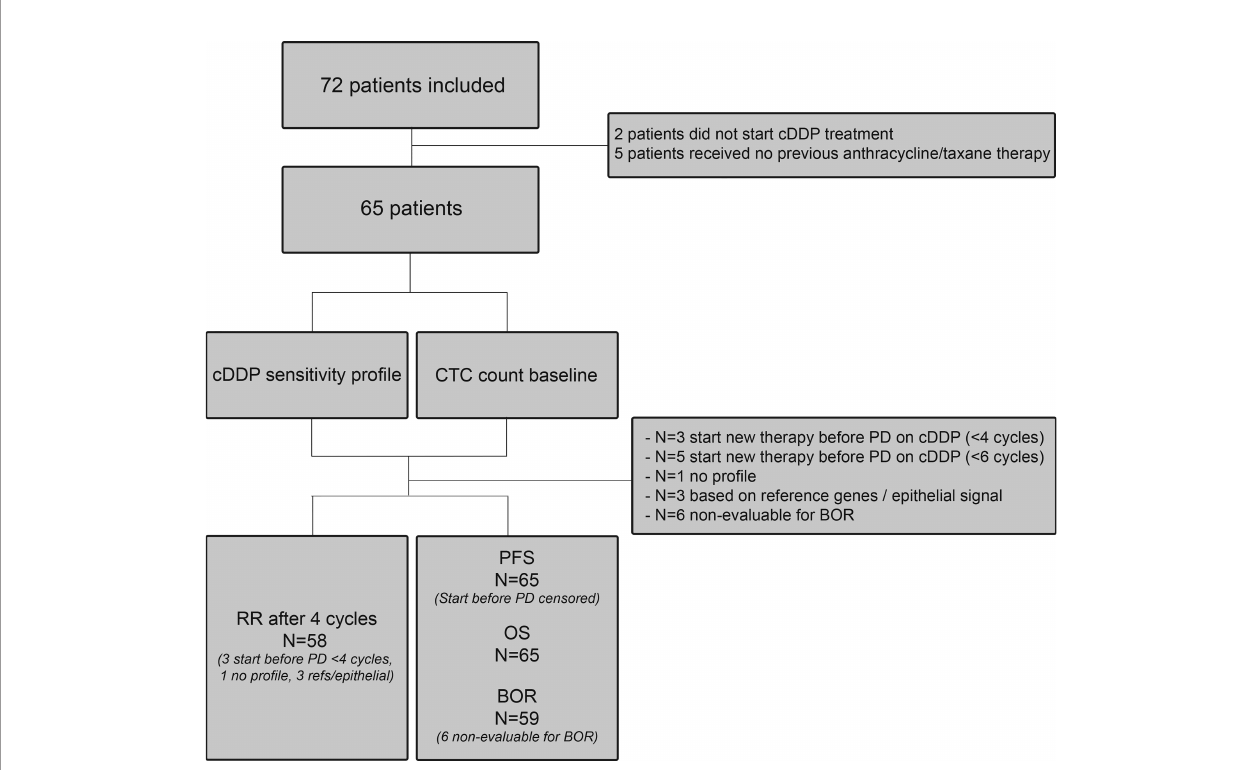
FIGURE 1 | Flow chart. Flow chart of all patients included in the study. RR, response rate; PFS, progression-free survival; BOR, best observed response; OS, overall response; PD, progressive disease; cDDP,